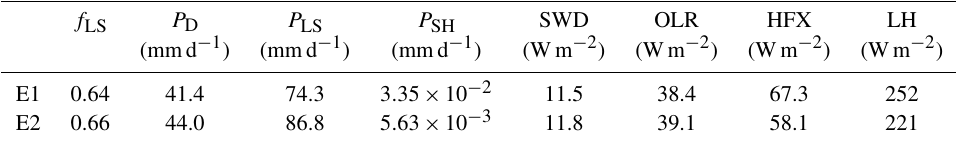
Table 2. Average values for a series of quantities for the two distinct SCM equilibria (E1 and E2) shown in Fig. 4. After f LS , the three types of precipitation (deep-convective P D , large-scale P LS , and shallow-convective P SH ) are shown, followed by the shortwave radiation to the surface (SWD), the outgoing longwave radiation at the top of the column (OLR), and the surface sensible (HFX) and latent (LH) heat fluxes. f LS P D P LS P SH SWD